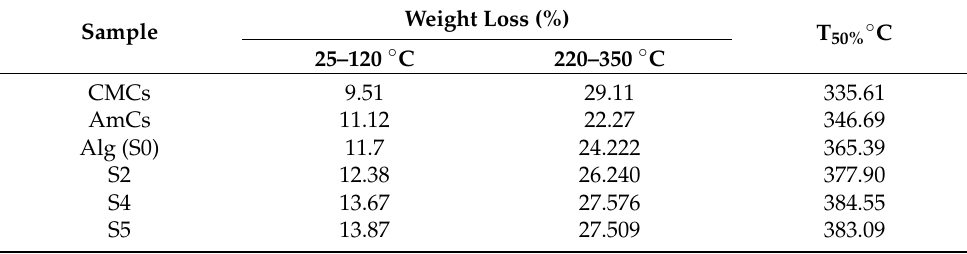
Table 2. TGA data for CMCs, AmCs, Alg (S0), Alg-CMCs (S2), and Alg-CMCs@AmCs (S4 and S5)